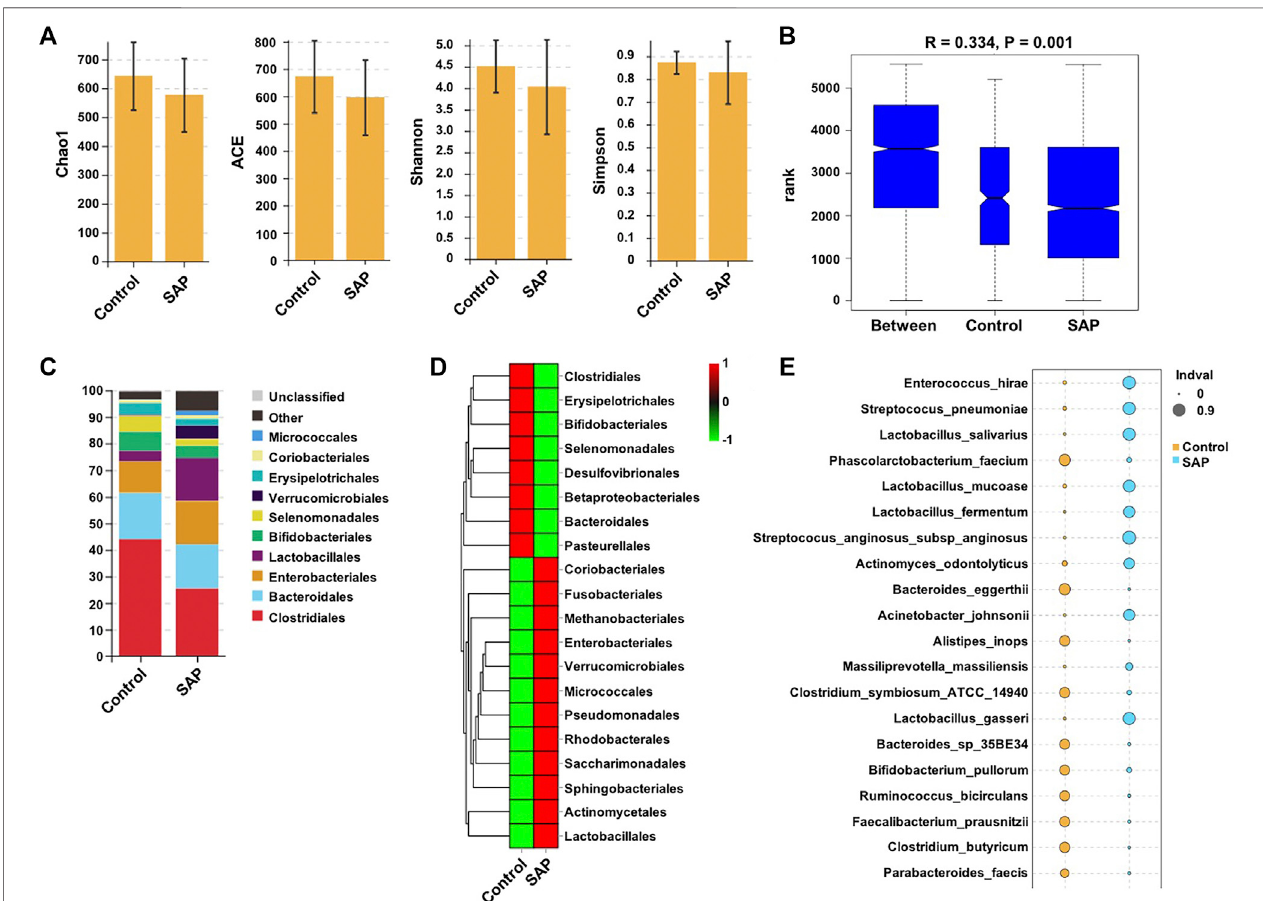
FIGURE1| DifferenceinspeciesofbacteriabetweencontrolandSAPgroups.16srRNAgenesequencingwasusedtodeterminetheabundanceandcomposition ofgutmicrobiotainfecalsamplesfrompatientswithSAPandcontrols. (A) Alphadiversity(Chao1,ACE,Shannon,Simpson)and (B) Betadiversity(Anosim)comparison between control and SAP groups. (C) The relative abundance of the microbiota at the order level was displayed using the stacked bar chart. (D) Heatmap showed the differences in microbiota abundance at genus level between SAP and control groups. (E) The indicator species analysis was conducted to screen the biomarker between SAP and control groups. SAP, severe acute